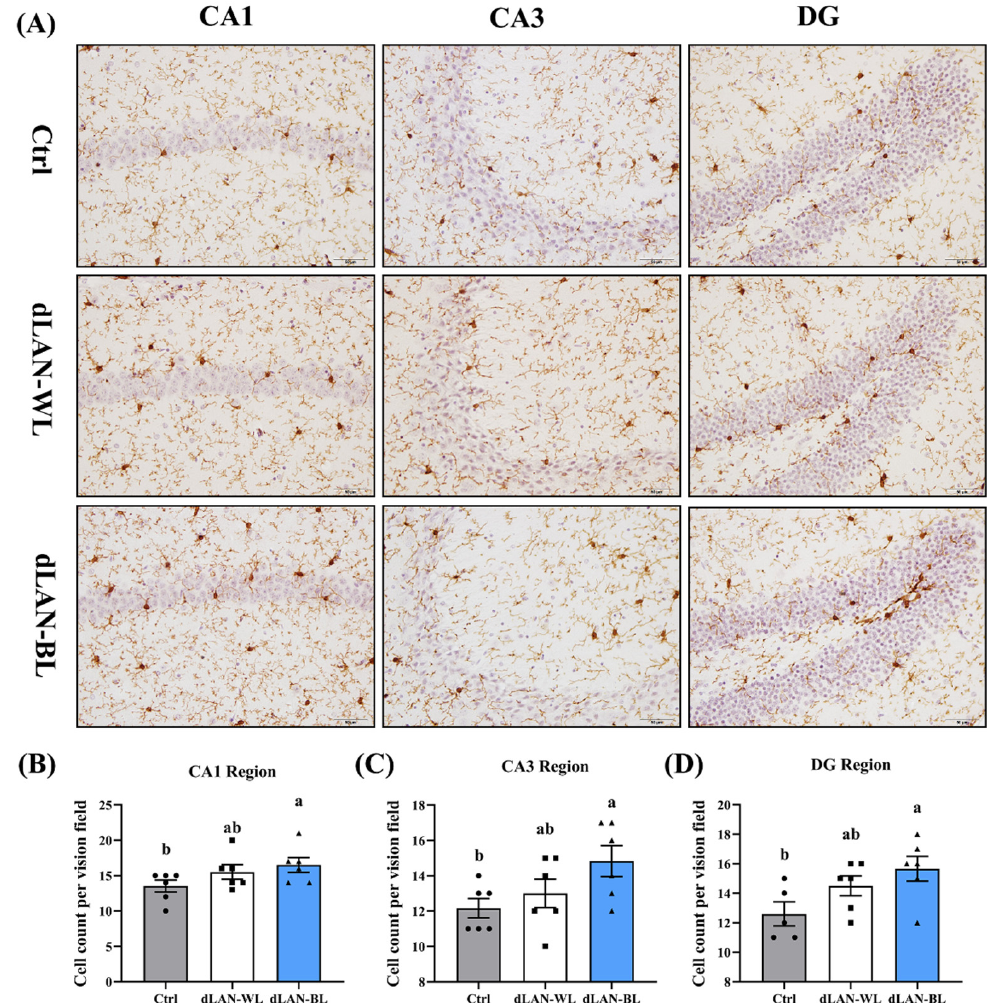
Figure 4. Effects of dLAN on the number of microglia in the CA1, CA3 and DG regions of the hippocampus. ( A ) Images of the immunohistochemical microglia in the different groups. The immunohistochemical results were processed using Image J. Bar =50 µ m. ( B ) Number of microglia in the hippocampal CA1 region ( n = 6). ( C ) Number of microglia in the hippocampal CA3 region ( n = 6). ( D ) Number of microglia in the hippocampal DG region ( n = 6). Differences were assessed using one-way ANOVA. The result represents the mean ± standard error of the mean. Values not sharing a common superscript letter (a,b) differ significantly at p < 0.05; those with the same letter (a,b) do not differ significantly ( p ≥ 0.05). Ctrl: control group, dLAN-WL: dim white light at night group, dLAN-BL: dim blue light at night group.